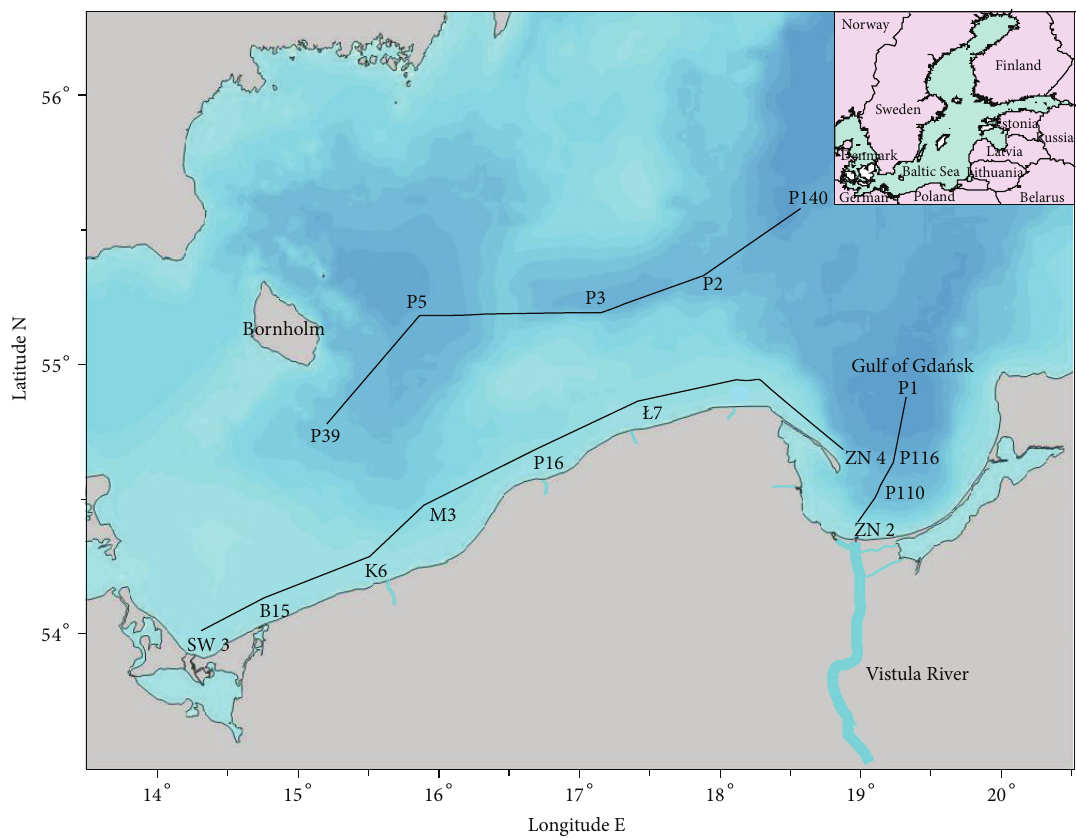
Figure 1: Localization of sampling